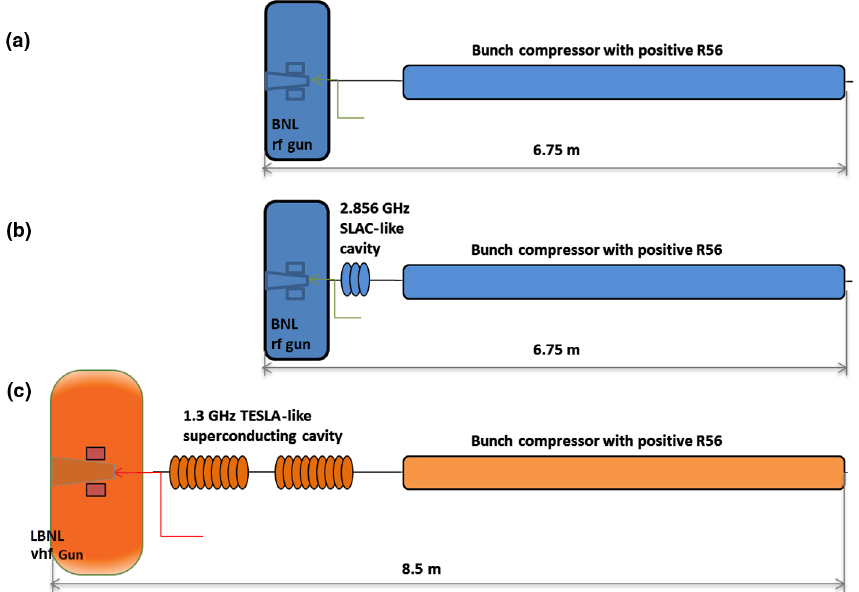
FIG. 1. Schematics of linac bunch compressors. (a) consists of the BNL photocathode rf gun and a bunch compressor constructed by several magnets. (b) consists of the BNL photocathode rf gun, a SLAC-like cavity at 2.856 GHz, and a bunch compressor. (c) consists of LBNL ’ s VHF gun, two TESLA-like superconducting cavities at 1.3 GHz, and a bunch